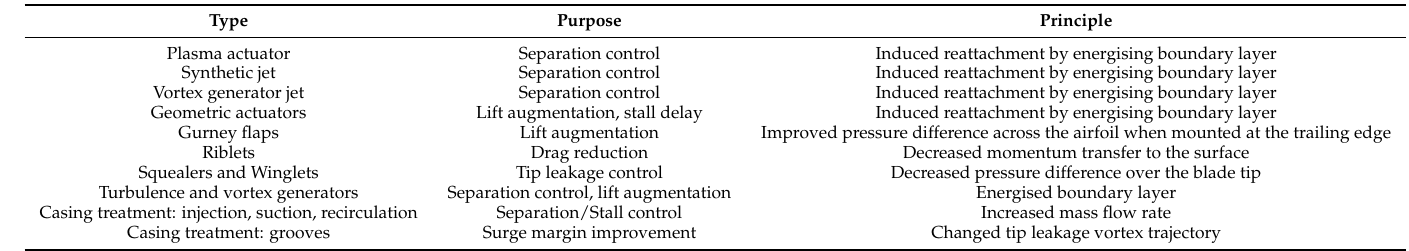
Table 11. Purpose of flow control